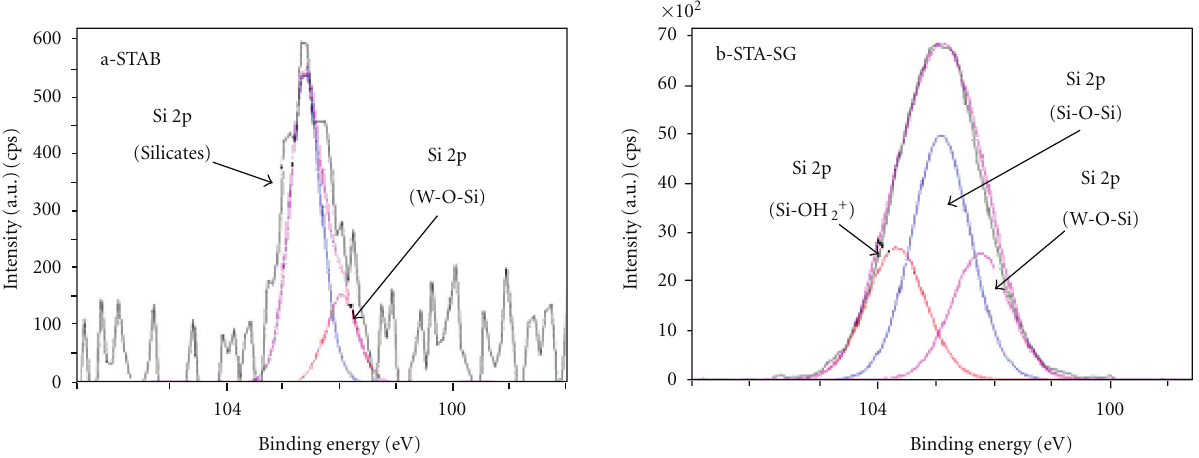
Figure 5: Narrow scan for Si2p (a) STAB and (b) STA-SG.